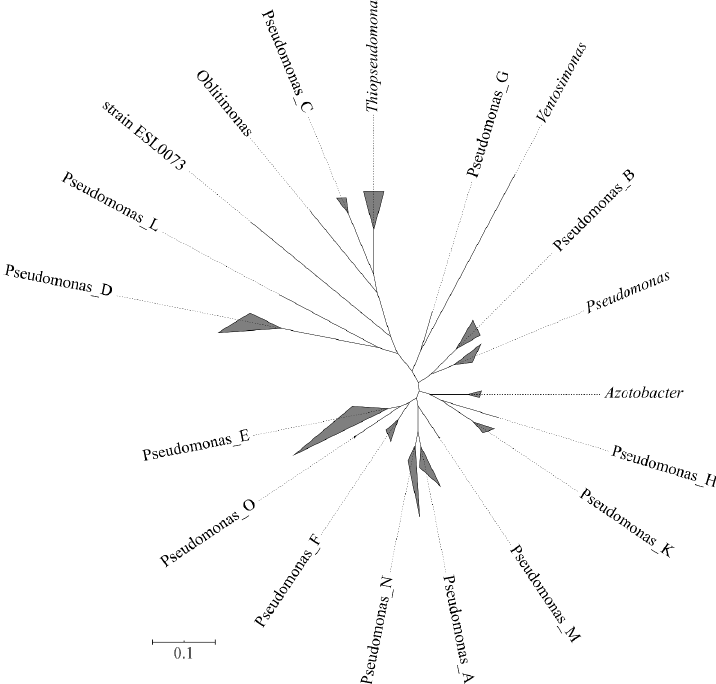
Figure 3. Phylogenetic tree of the Pseudomonadaceae genera based on the GTDB taxonomy. Triangles are proportional to the sequence divergence among species included in each genus. Bar indicates sequence divergence.